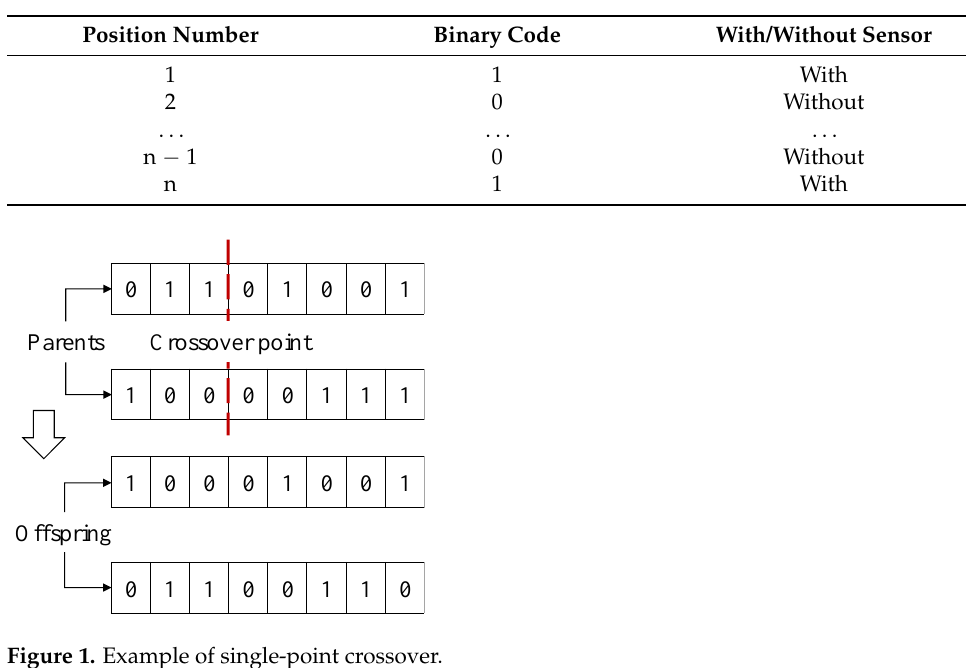
Table 1. Example of binary coding of sensor placement positions.